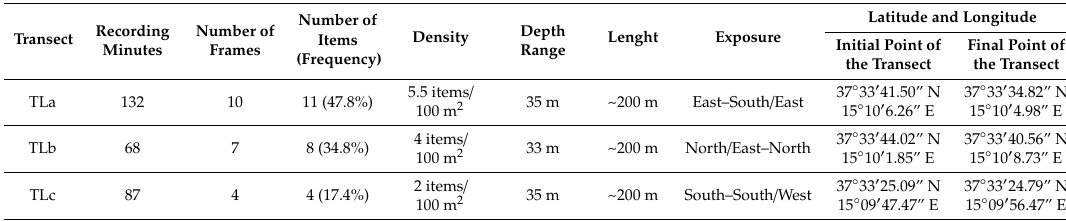
Table 1. Summary of the data on the ROV transects.